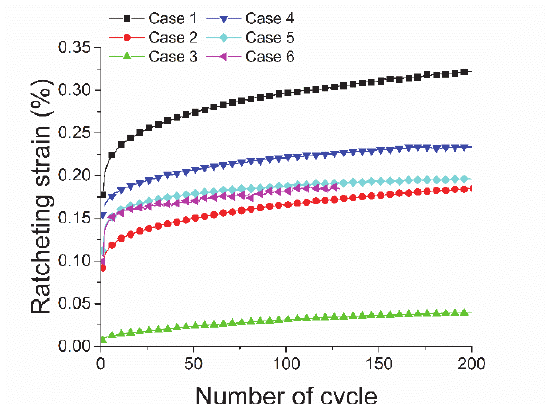
Figure 4: Evolution of ratcheting strain under various loading